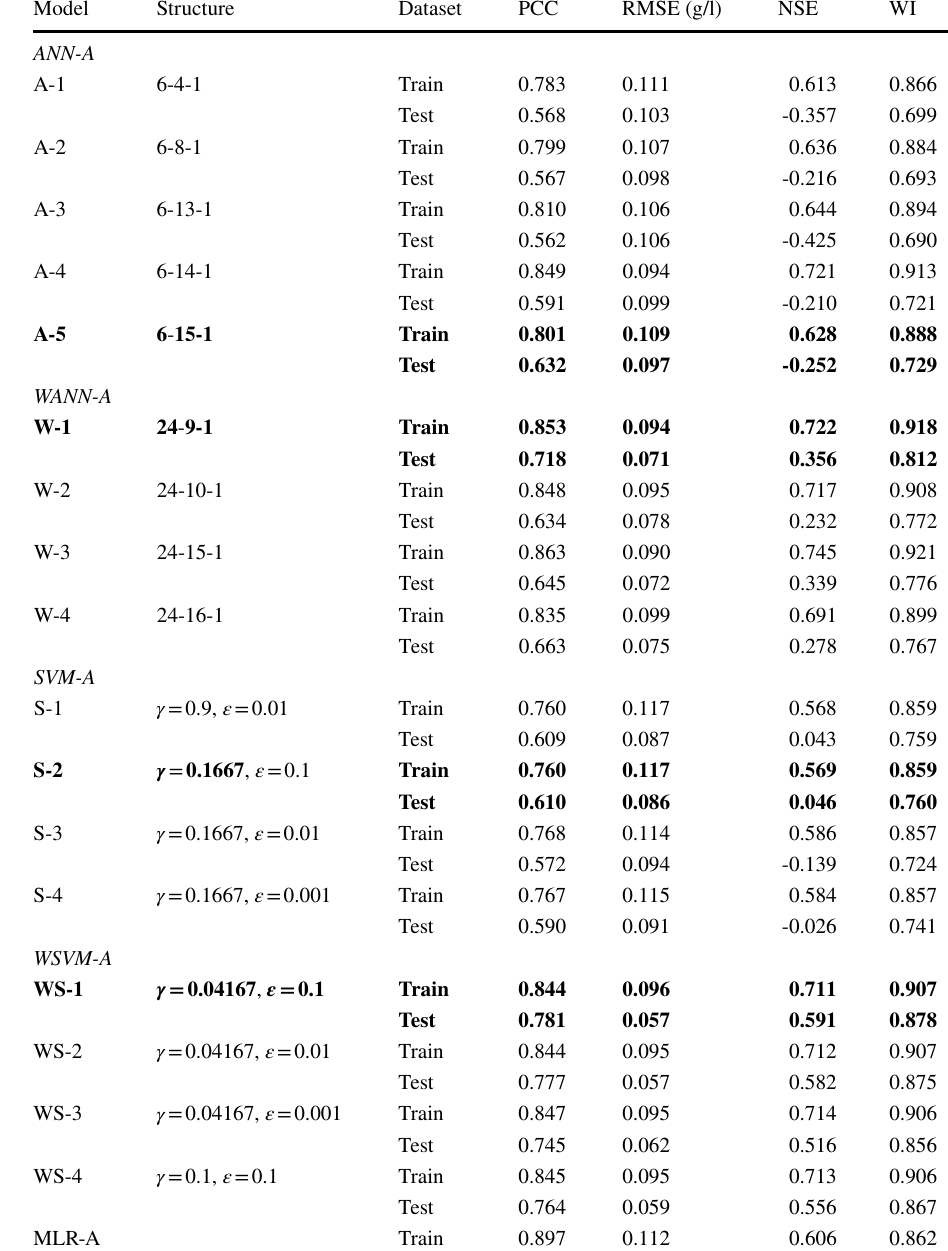
of ANN, WANN, SVM, WSVM, and MLR models during the training and testing at the Adityapur